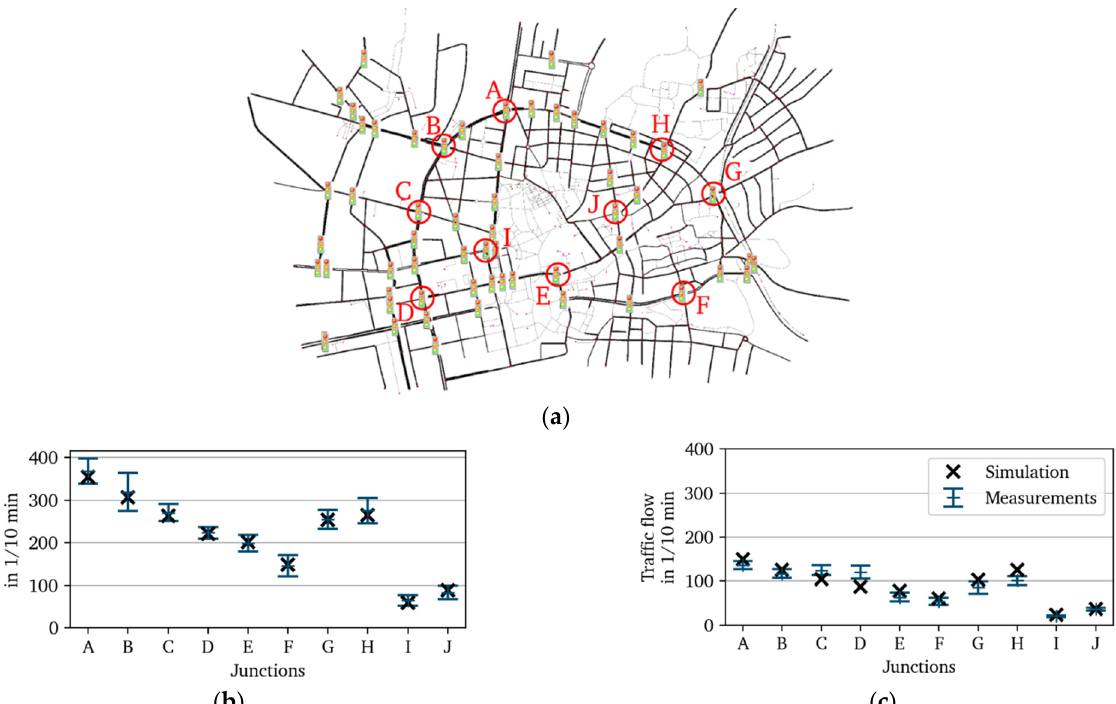
Figure 4. Cumulative traffic flows at several junctions displayed in ( a ) in the simulation and from measurement data. The traffic flows are shown during ( b ) rush hour and during ( c ) off-peak period. The error bars denote the standard deviations of the traffic flow measurements over the weekdays of one